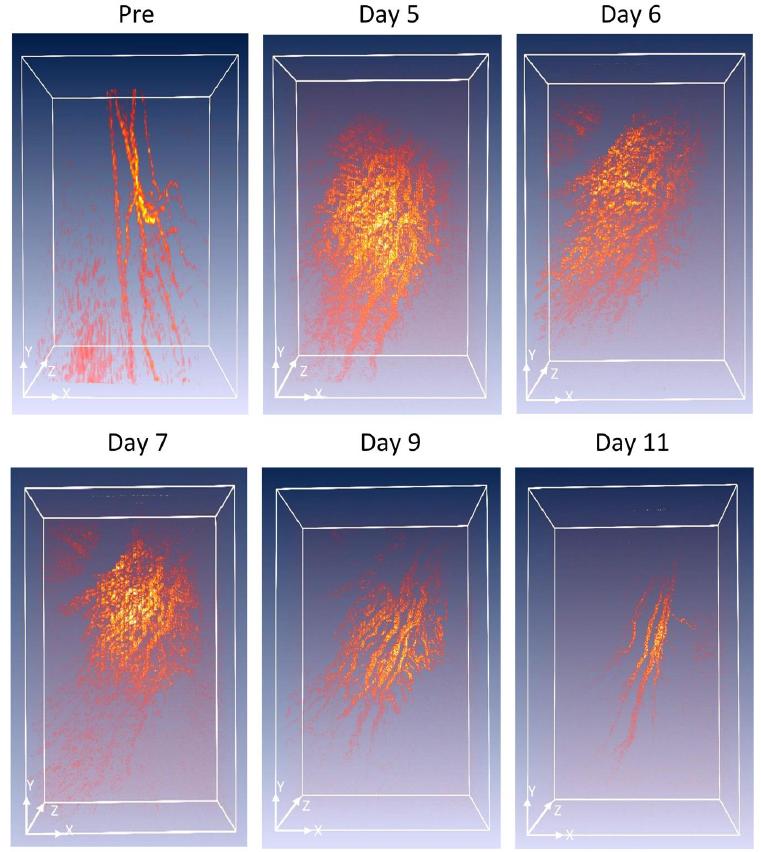
Figure 5. 3D rendering PAM images.